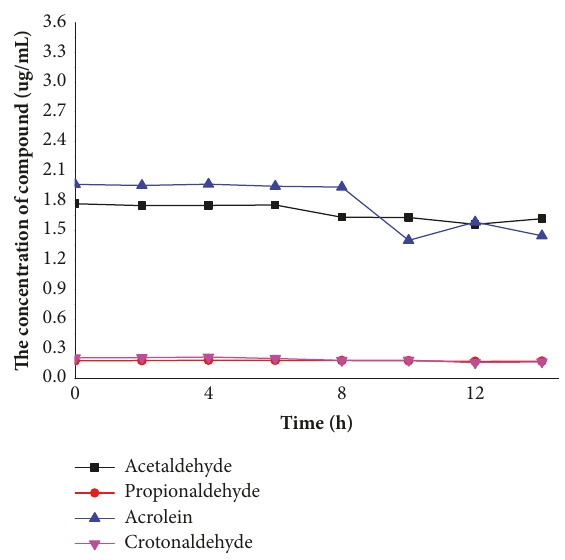
Figure 3: The stability of acetaldehyde, propionaldehyde, acrolein, and crotonaldehyde in methanol at room temperature.